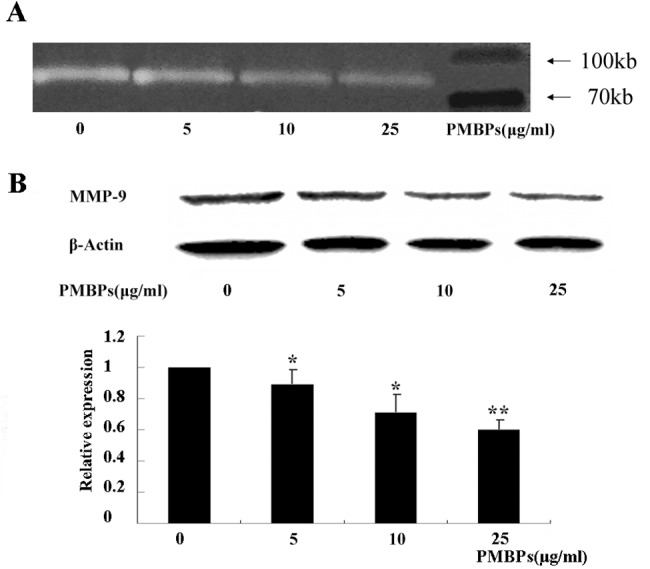
PMBPs suppress MMP-9 activity and expression.The cells were treated with PMBPs (0, 5, 10, 25 μg/ml) for 24 h. (A) Activity of MMP-9 in the cell supernatant at various concentrations of PMBPs was examined by gelatin zymography assay. The white bands represent MMP-9 mediated gelatin digestion. (B) The protein expression of MMP-9 in A2780 cells at various concentrations of PMBPs was evaluated by Western blot. Histogram shows mean level of MMP-9 (±SD) from three independent experiments. MMP-9 protein level was expressed relative to loading control, β-Actin, and standardized to the non-treated control group. *P<0.05 and **P<0.01 compared to the control group.